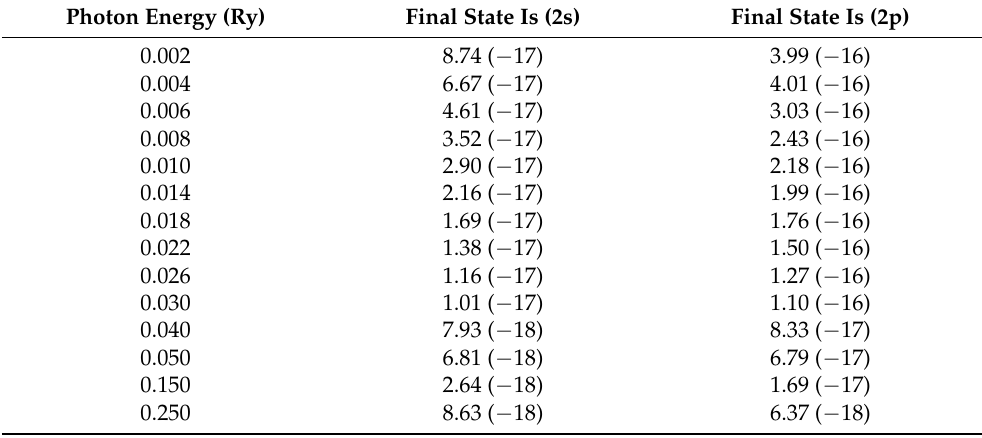
Table 12. Cross sections (cm 2 ) for the photodetachment of the 3 P e state of a negative hydrogen